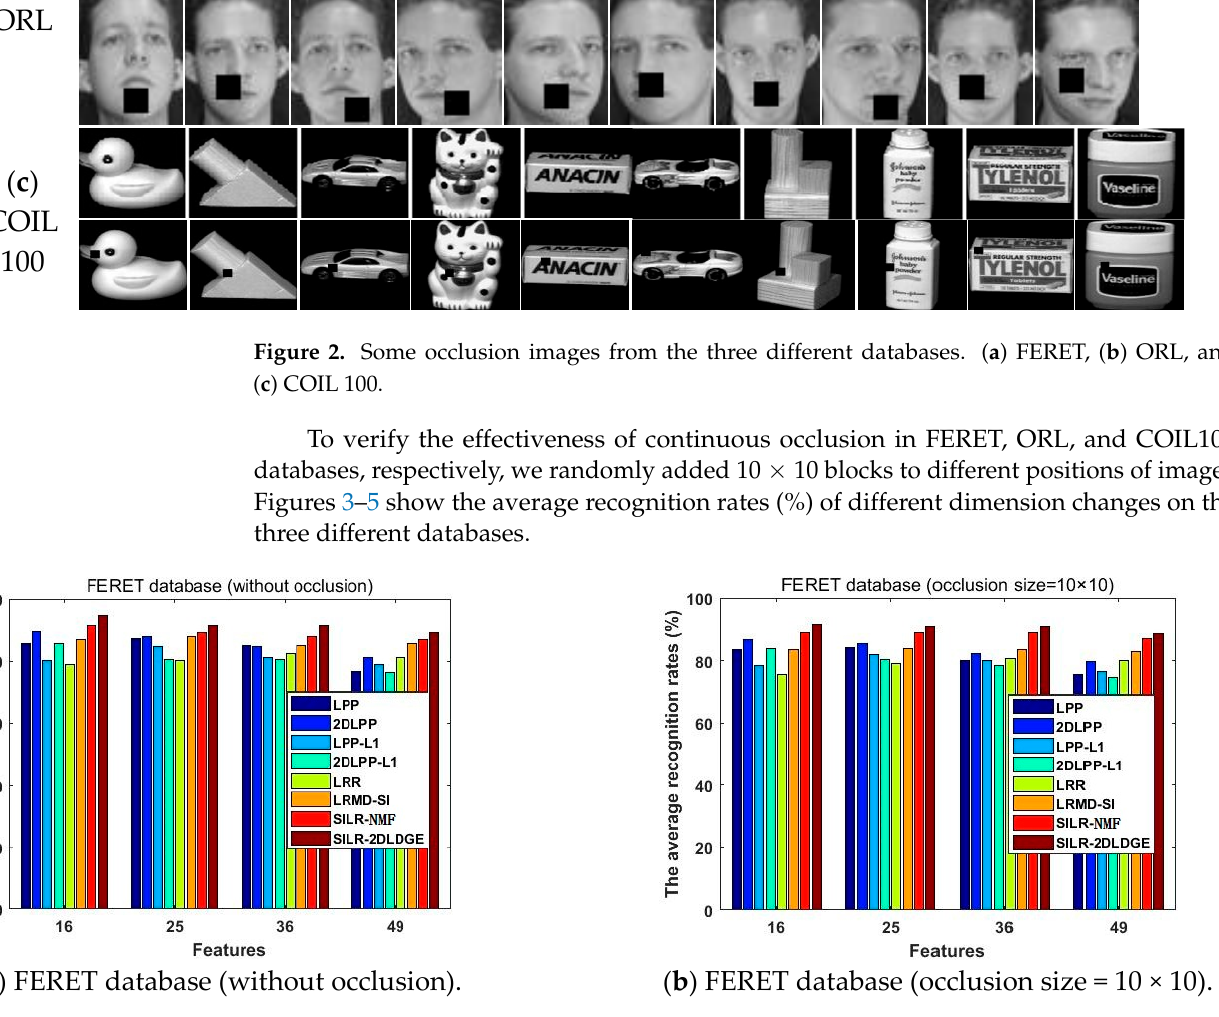
Figure 3. The average recognition rates (%) of the eight algorithms in the FERET database vary with the dimension.